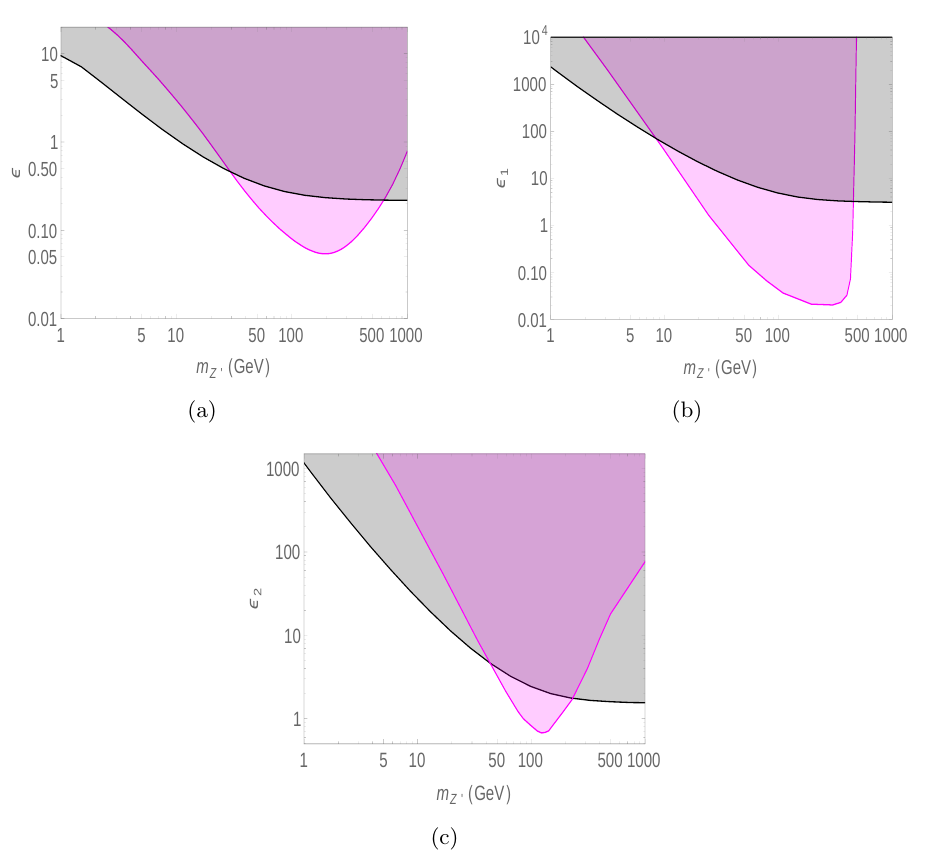
Figure 2 . Constraints on Z 0 induced NSI in presence of interactions expressed in eq. (4.1), (4.3) and (4.4) respectively as functions of Z 0 mass. The pink and grey regions are excluded from LHC and IceCube